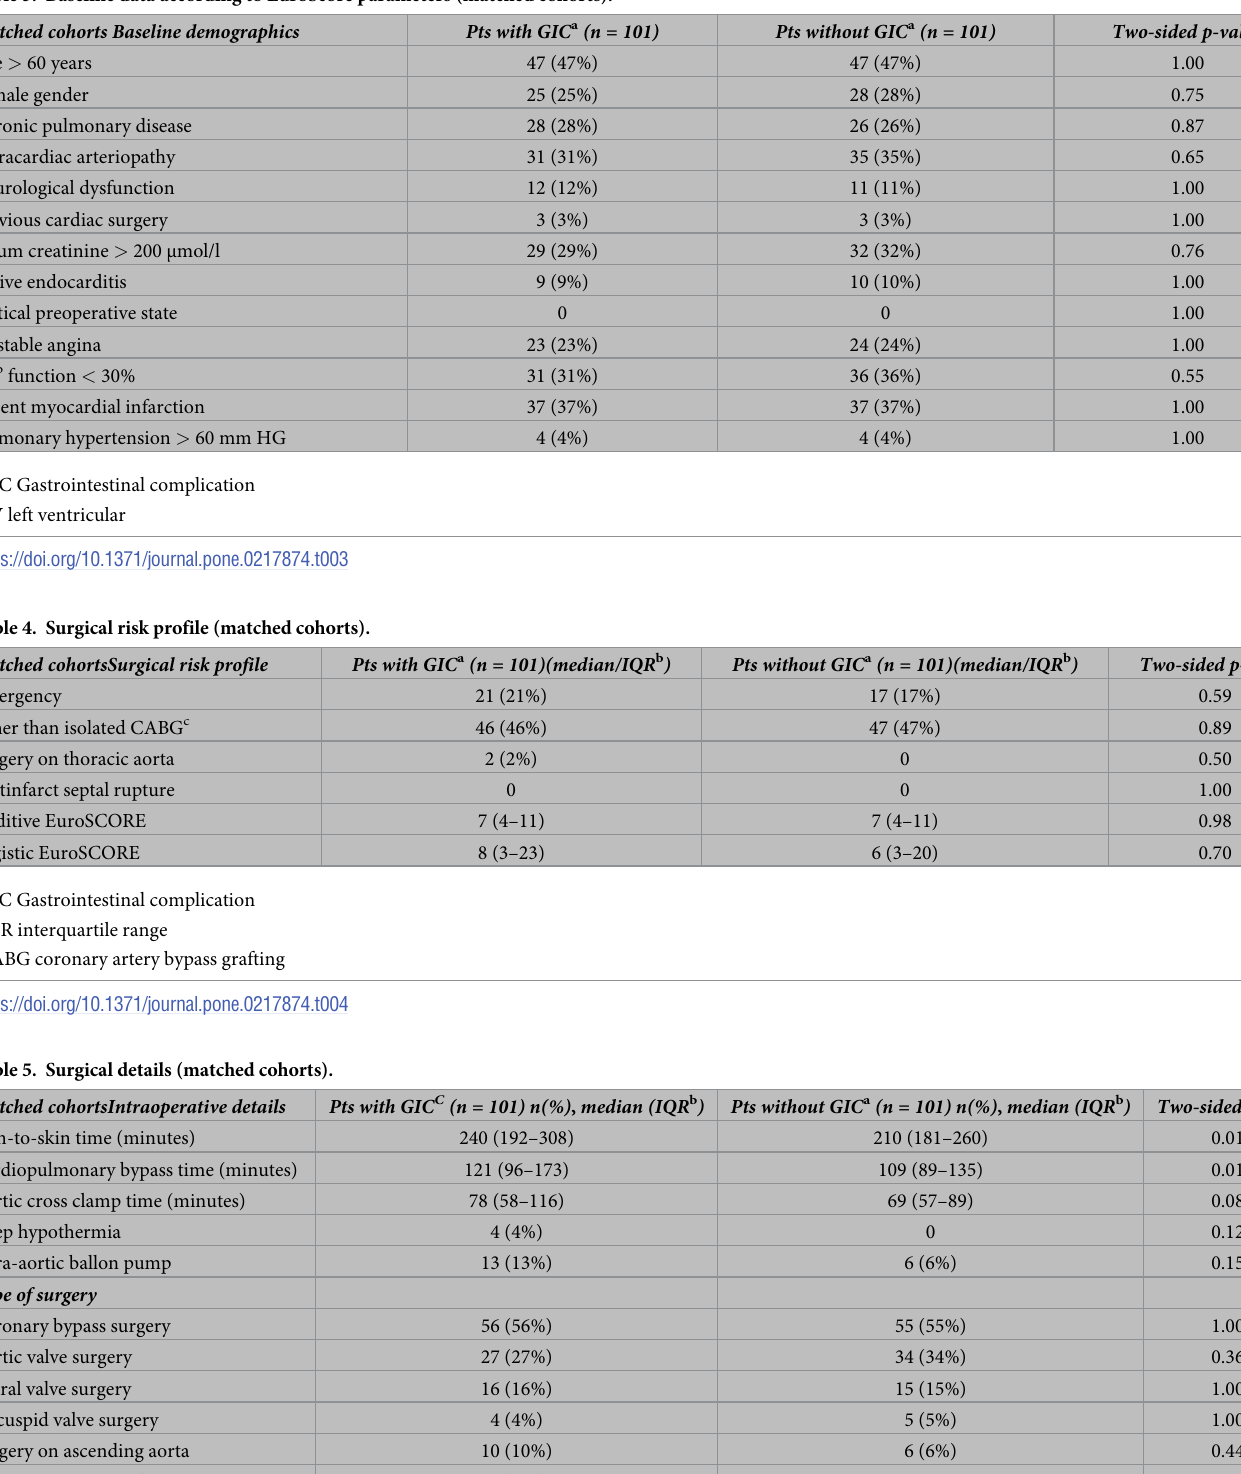
Table 3. Baseline data according to EuroScore parameters (matched cohorts).